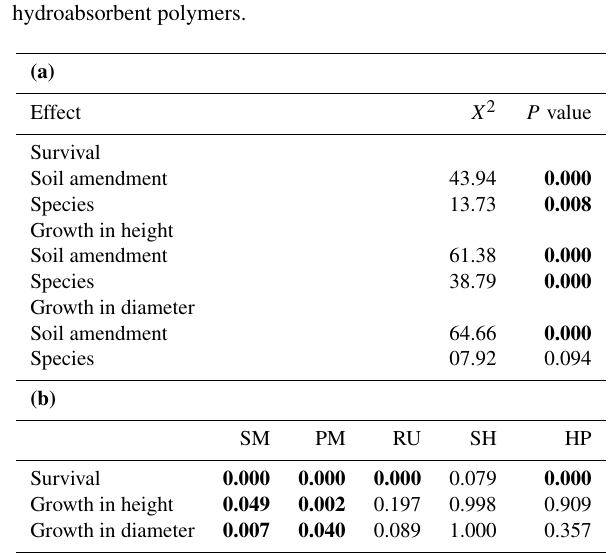
Table 1. (a) Vegetation measurement: likelihood ratio test for fixed effects on fixed effects soil treatment in species based on gener- alized mixed effect models (GLMs) for plant survival and growth 30 months after the afforestation. (b) Post hoc multiple comparison for observed means (Tukey’s test; P <0.05). SM: straw mulch; PM: mulch with chipped branches of Aleppo pine ( Pinus halepensis L.) ; RU: sewage sludge; SH: sheep manure compost; HP: TerraCottem hydroabsorbent